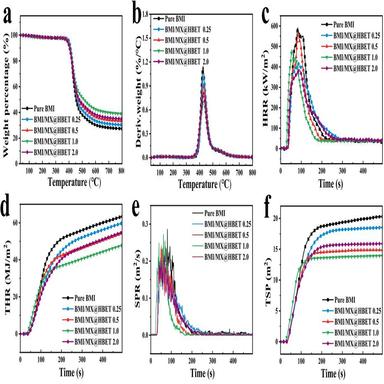
(a) TGA and (b) DTG vs. temperature curves of BMI and its composites under nitrogen; (c)HRR, (d) THR, (e) SPR and (f) TSP cone curve of BMI and its composites.